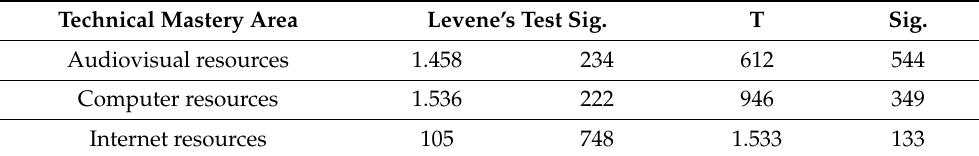
Table 6. Student’s t for the gender variable and the technical mastery of different resources. Technical Mastery Area